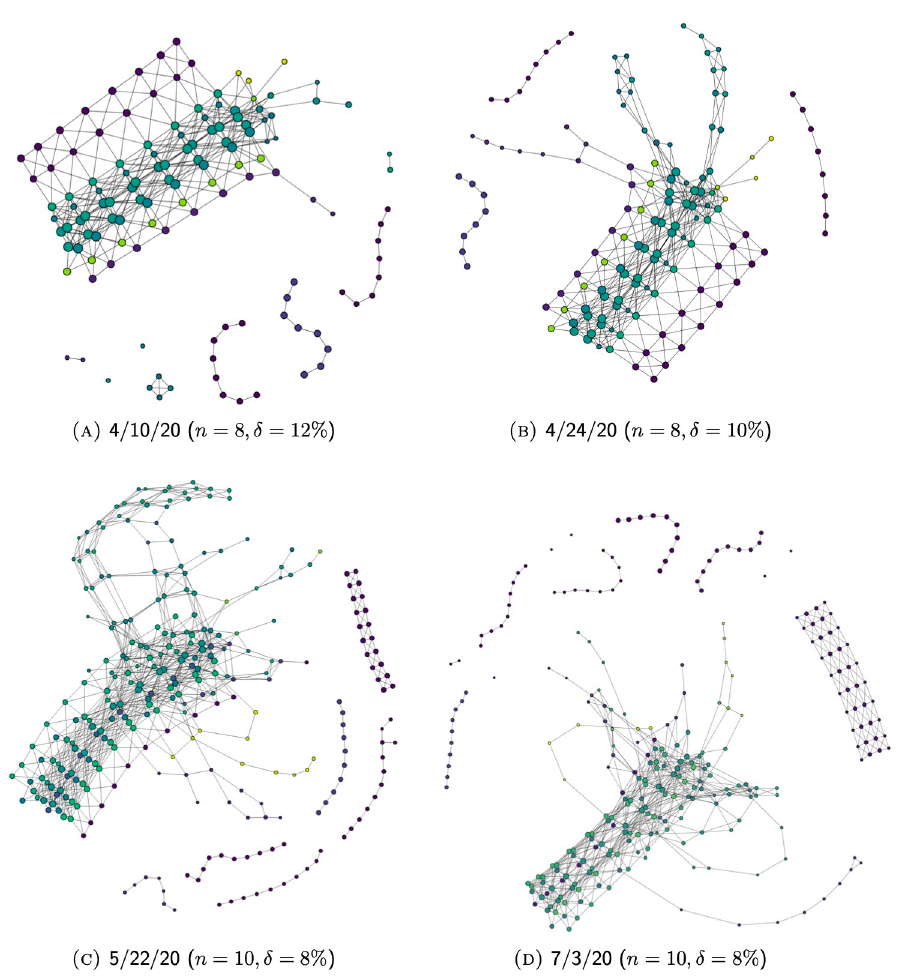
Fig 12. The evolution of Mapper graphs over time for filtered data (see Section